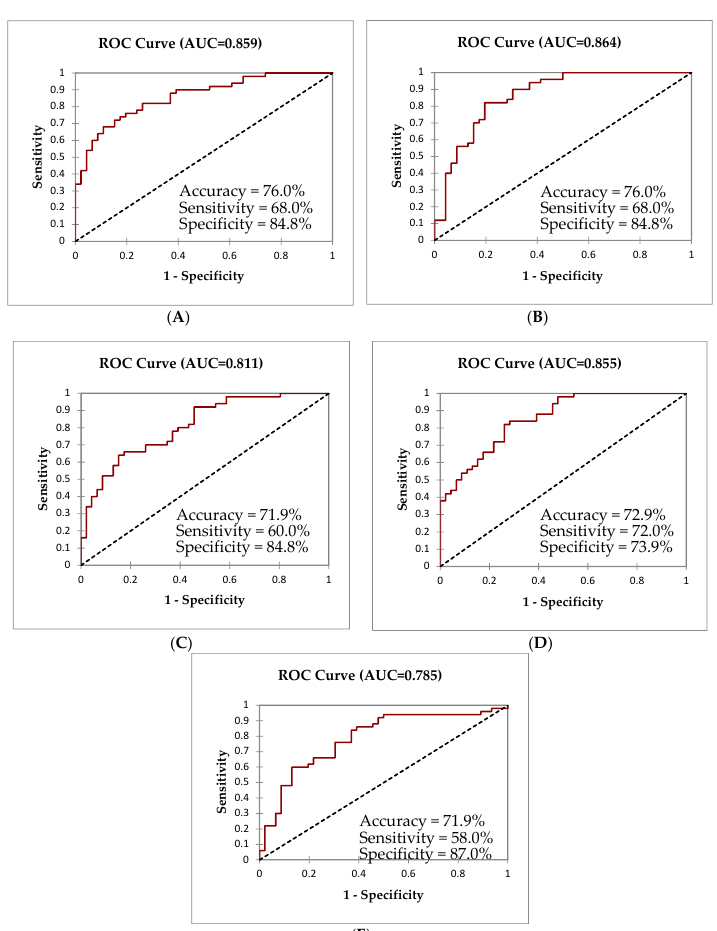
Figure 4. Receiver operating curve (ROC) for the models predicting an asthmatic or healthy child classification based on the clusters generated in the AHC analysis. The corresponding predictors for each curve are presented in Table 4. For eosinophils: ( A ) ROC for Cluster 1, ( B ) Cluster 2, and ( C ) for Cluster 3. For neutrophils: ( D ) ROC for Cluster 1 and ( E ) for Cluster 3.